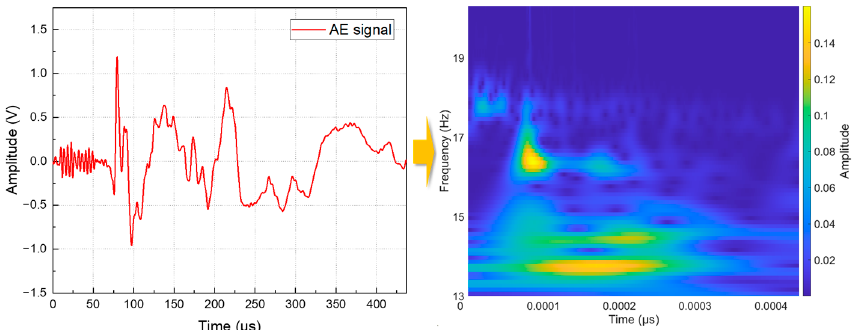
Figure 4. The time-domain signal of a typical AE event and the corresponding time–frequency scale diagram.